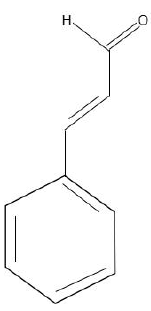
Figure 1. Chemical structure of cinnamaldehyde.